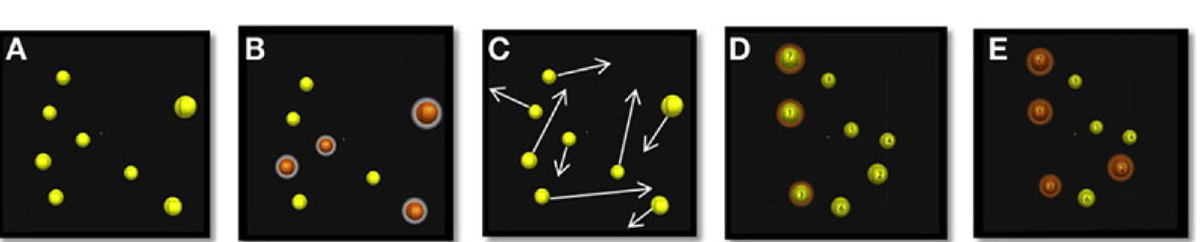
Figure 2. Breakdown of a 3D-MOT trial. ( A ) Presentation: all spheres appear. ( B ) Identification: target spheres are identified in red. ( C ) Movement: spheres move through space following a linear trajectory. ( D ) Response: participant attempts to identify targets. ( E ) Feedback: correct targets are